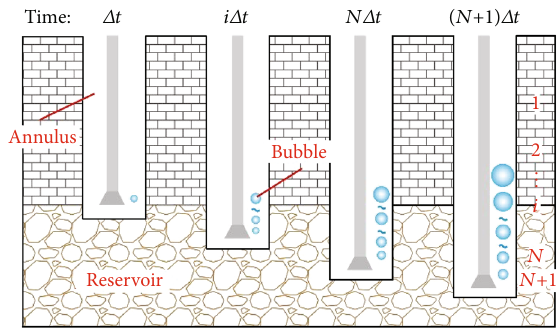
Figure 1: Schematic of bubbles rising and expansion in the annulus during a kick ( L : initial well depth; i : the serial number of bubbles, where 1 is the earliest and N + 1 is the